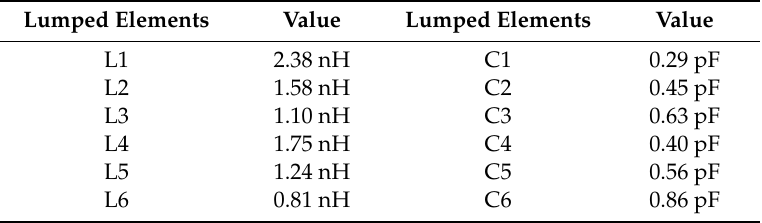
Table 1. The ideal lossless elements values of the traditional Chebyshev filter.